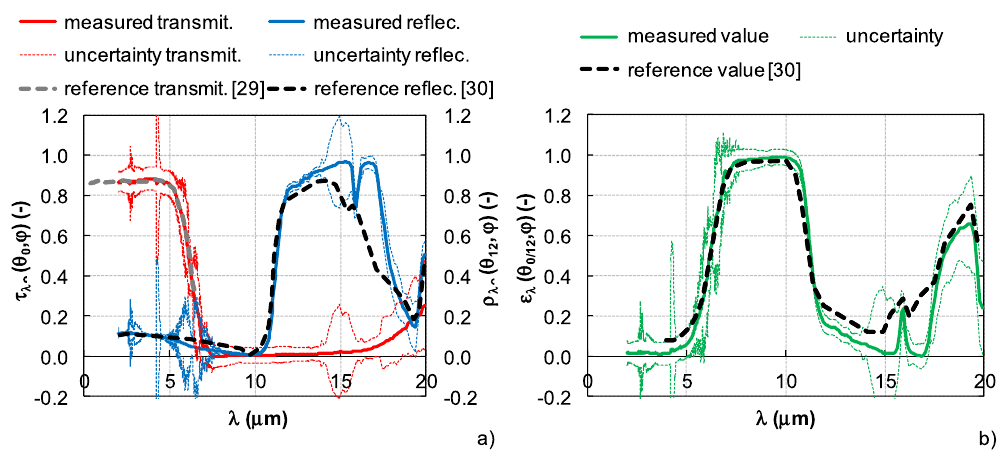
Figure 8. The results of semitransparent bulk material – sapphire (1 mm thickness). ( a ) Measured transmittance and reflectance vs. reference values. ( b ) Evaluated emissivity vs. reference